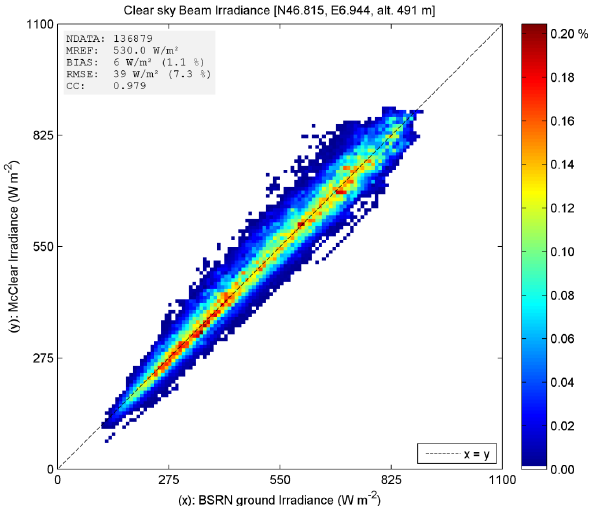
Fig. 5. Scatter density plot between BSRN 1min clear-sky data and McClear. Payerne. Beam irradiance on horizontal surface.